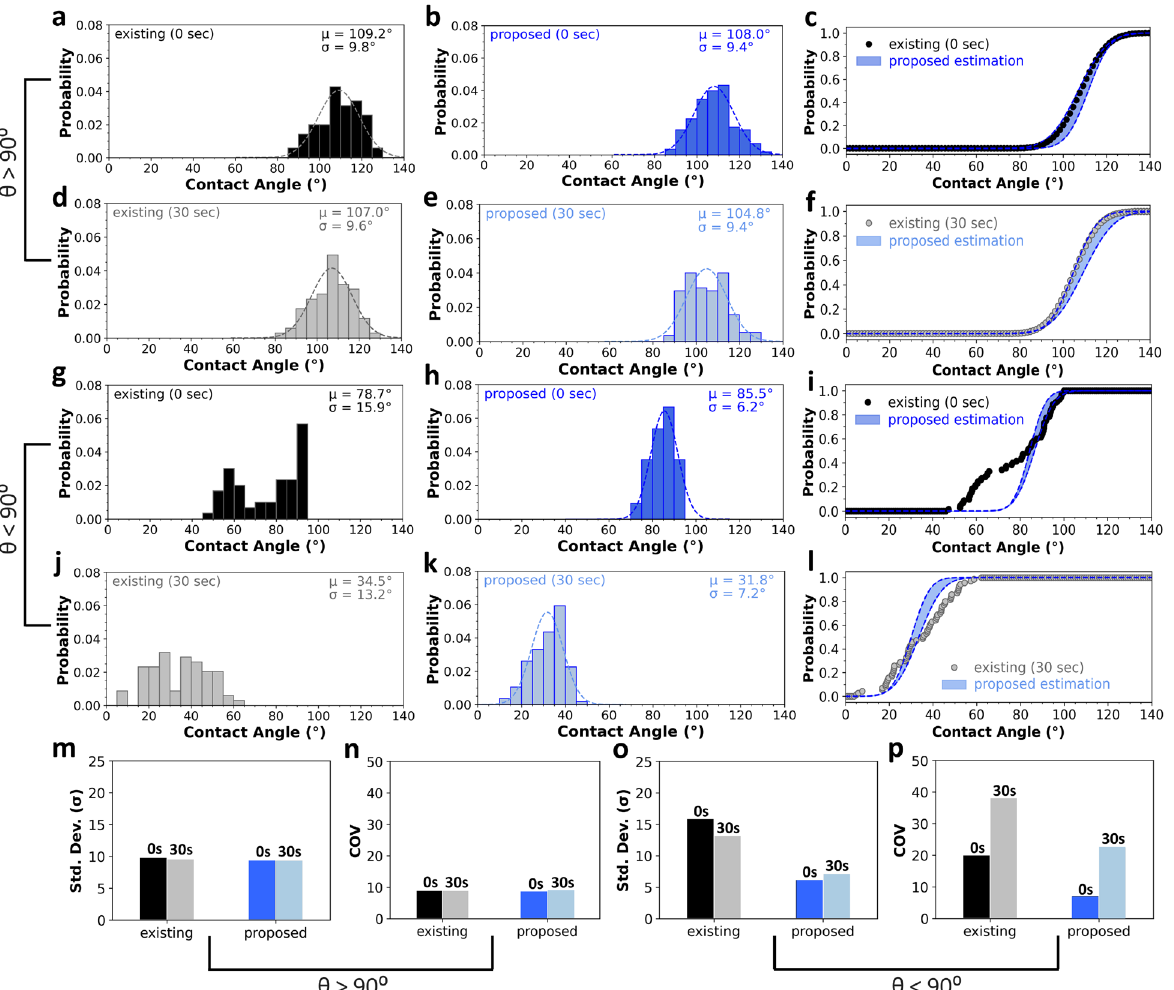
Figure 4. CA estimations by the existing and proposed approaches: surface wettability estimates on ( a–f ) hydrophobic (θ > 90°), and (g to l) hydrophilic (θ < 90°) surfaces at 0 and 30 s from solid–liquid interaction, and their corresponding statistical parameters including (m, o) standard deviation (σ), and (n, p) coefficient of variation (COV = µ/σ 100). Specifically, in column 1 ( a,d,g,j ) the fitting method (existing approach), and in × column 2 ( b,e,h,k ), the CNN model (proposed approach) is used to evaluate the CAs. Furthermore, column 3 ( c,f,i,l ) performs a comparison of CAs estimated by the two approaches (on each row) using the Bayesian statistics. Analysis of surface wettability on hydrophilic surfaces (third and fourth subplots of the third column) reveals a disagreement between the two approaches. Also, the COV of the CAs measured by the existing approach (at 30 s) exceeds 30% and consequently is not considered accurate, while the proposed approach presents more accurate estimates on hydrophilic